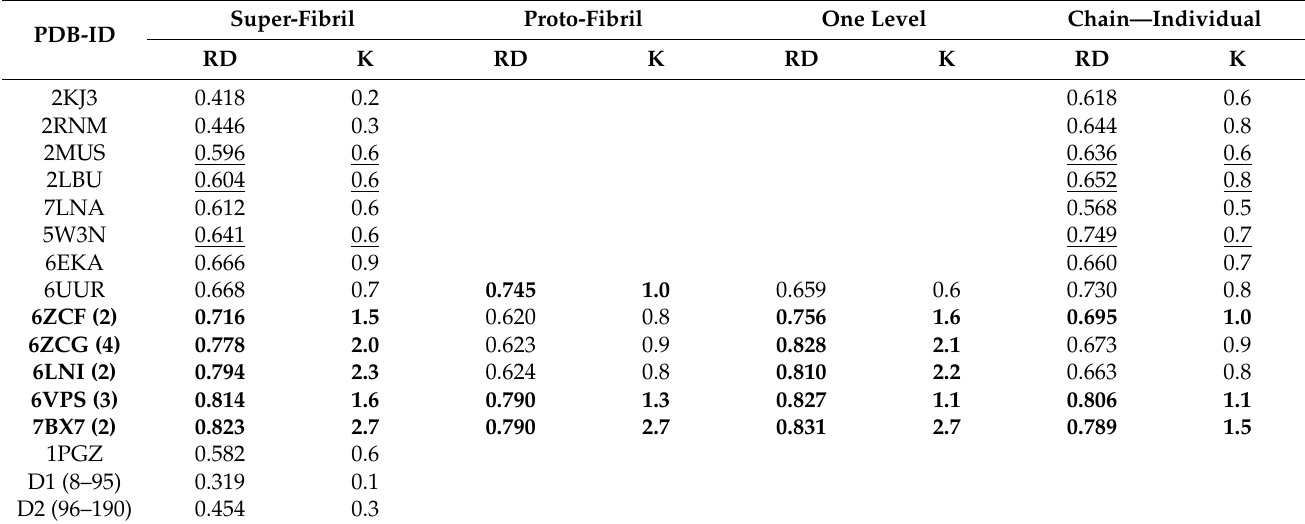
Table 6. List of amyloid proteins appearing in the PDB database after the use of the keyword “amyloid.” A set of parameters was provided for both the proto-fibril and super-fibril forms as well as for the single chain and the common floor (in the case of a super-fibril). The number of proto-fibrils included in the super-fibril is given in brackets. The 1PGZ item is a protein in globular form belonging to the hnrnpa family added to the amyloid pool to allow for comparative analysis against 7BX7. The values in bold—the highest discordance versus micelle-like hydrophobicity distribution. The underlined positions—examples with individual chain of higher RD status with respect to